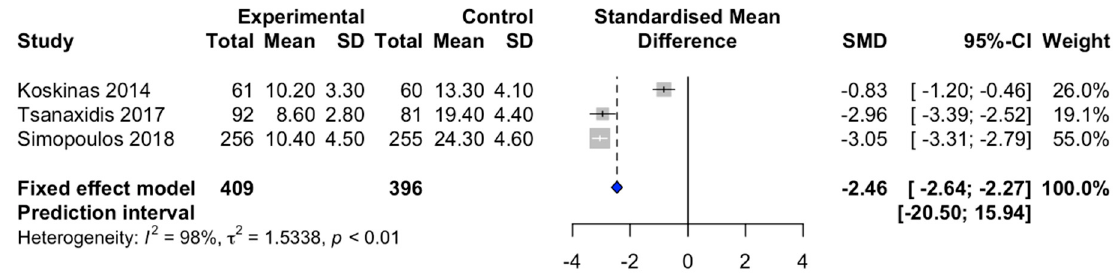
Figure 4. The forest plot meta-analysis showing sinus rhythm restoration time of the ranolazine plus amiodarone group and the amiodarone alone group.